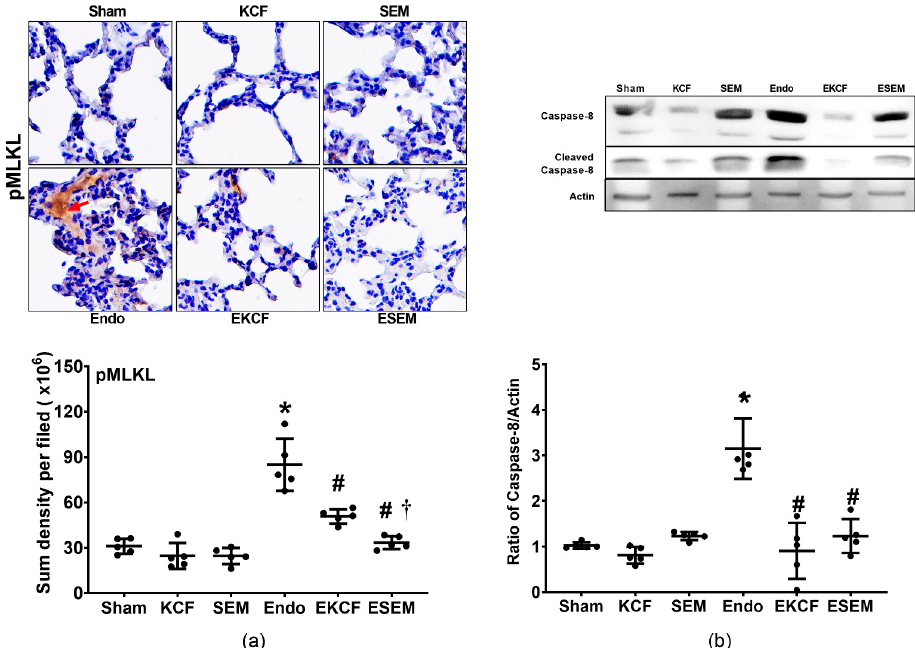
Figure 6. Lung necroptosis status. ( a ) Representative microscopic images of phosphorylated mixed lineage kinase domain-like pseudokinase (pMLKL, the indicator of necroptosis, marked by the red arrow, 200 × ) in lung tissues assayed using immunohistochemistry analysis and the sum of the pMLKL signal intensity. ( b ) Representative gel images of cleaved caspase-8 and actin (the internal standard) in lung tissues assayed using immunoblotting assay and the relative band density of cleaved caspase-8/actin in lung tissues. All assays were measured at 24 h after endotoxin or normal saline administration. Sham: the normal saline group. KCF: the normal saline plus the KCF18 peptide group. SEM: the normal saline plus the SEM18 peptide group. Endo: the endotoxin group. EKCF: the endotoxin plus the KCF18 peptide group. ESEM: the endotoxin plus the SEM18 peptide group. Data were obtained from five mice in each group and presented as the mean ± standard deviation. * p < 0.05, versus the Sham group. # p < 0.05, versus the Endo group. † p < 0.05, the ESEM group versus the EKCF group.